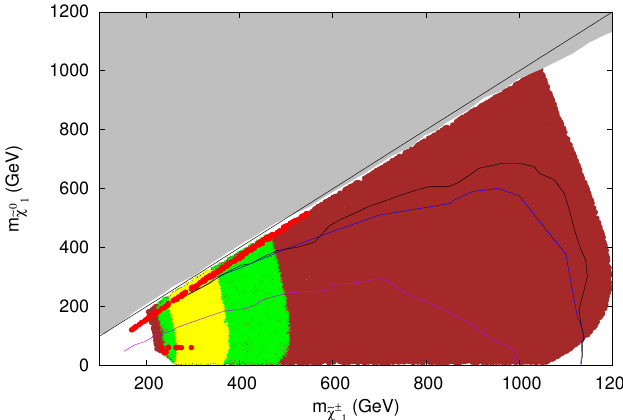
Figure 1 . The black line represents the exclusion contour in the m simpli(cid:12)ed model (see text) obtained by the ATLAS collaboration from trilepton searches at 13 TeV LHC [16]. The blue line shows the exclusion obtained by our simulations in the closely related LWLS model. The area enclosed by the magenta curve is excluded by the ATLAS slepton search at Run II (see text). The brown, green and yellow regions are consistent with the a (cid:22) data at 3 (cid:27) , 2 (cid:27) and 1 (cid:27) levels respectively. The red points satisfy WMAP/PLANCK data of the DM relic density. The grey region at the upper left corner is disfavoured